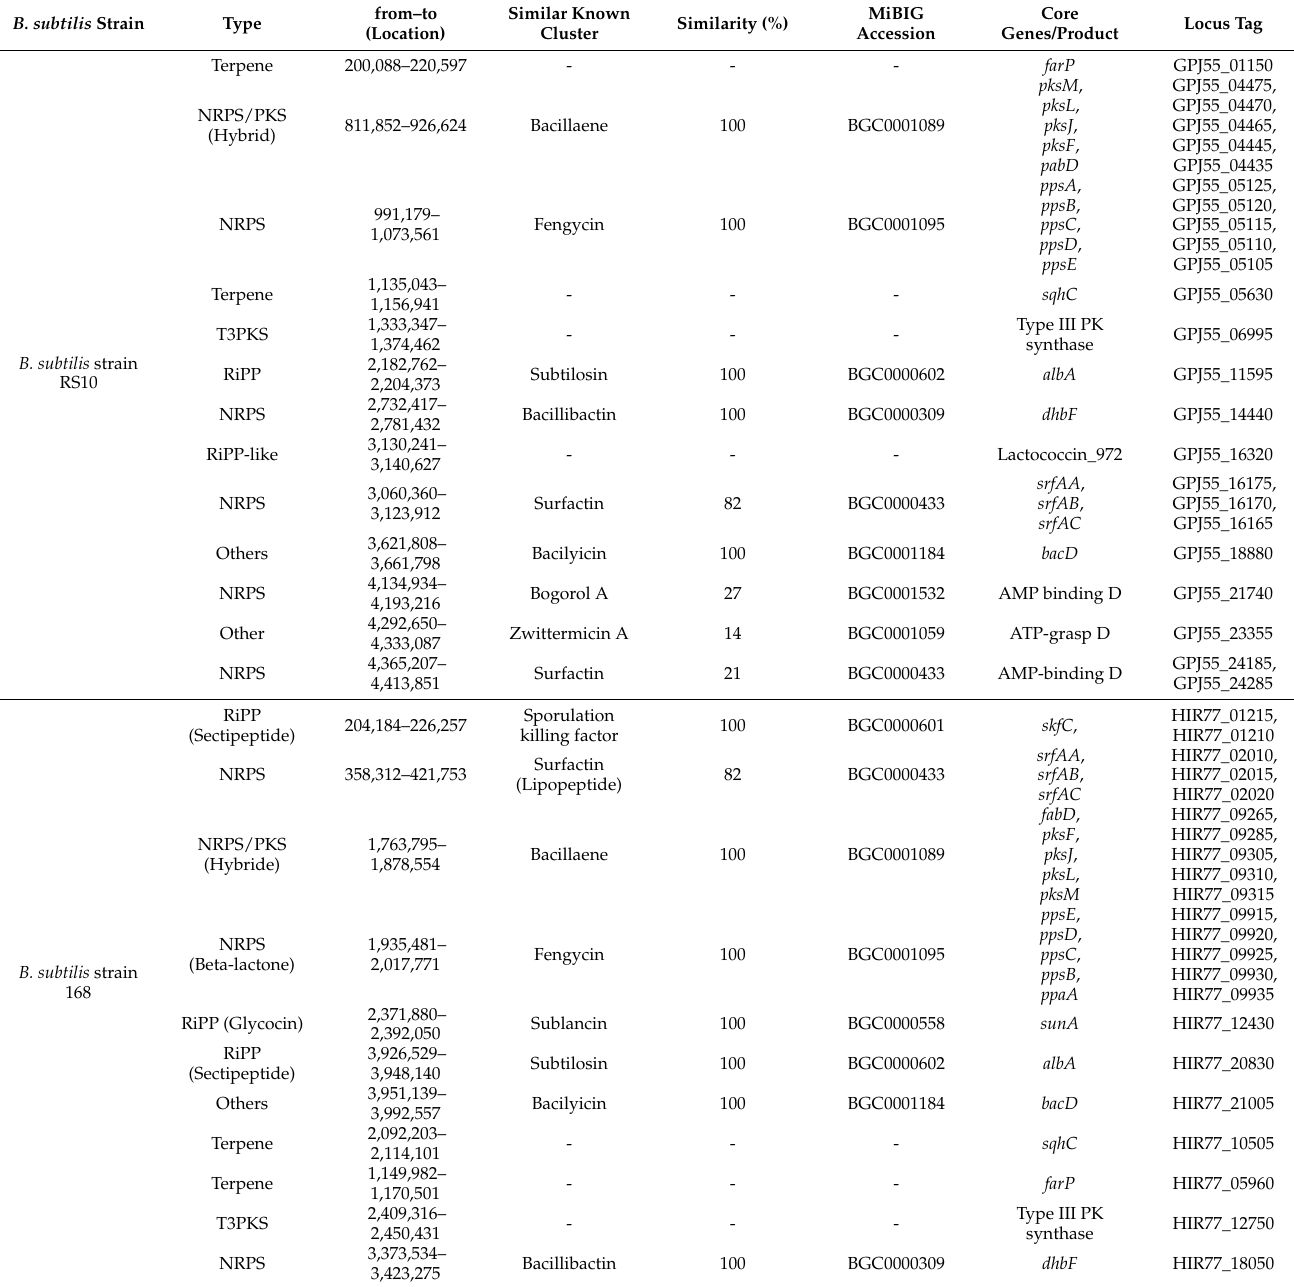
Table 1. Comparison of biosynthetic gene clusters (BGCs) in the Bacillus subtilis strain RS10 and the reference strain B. subtilis 168